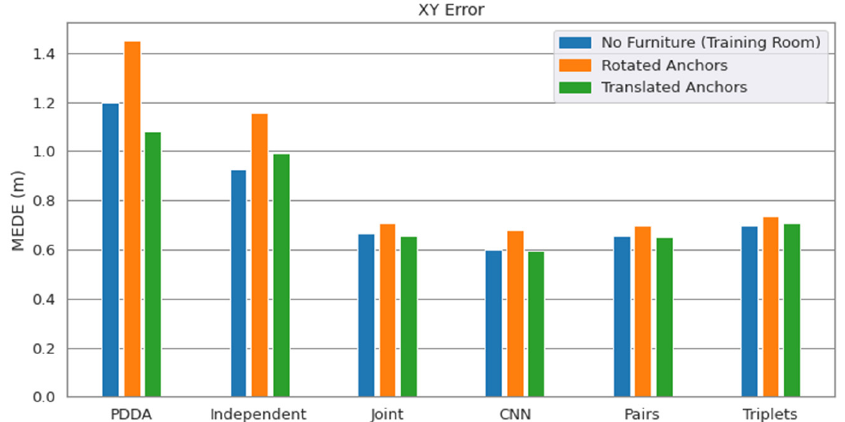
Figure 10. Performance degradation when the anchor points are rotated by 5° or translated by 10 cm.